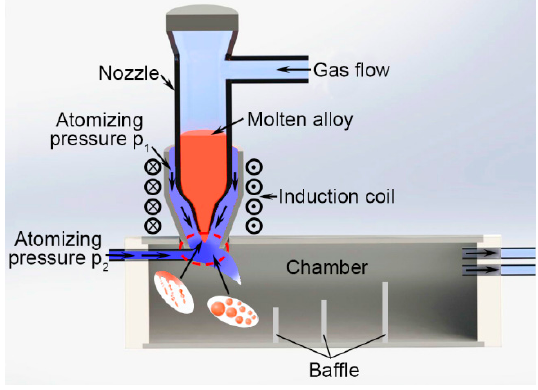
Figure 1. Schematic illustration of the gas atomizer.